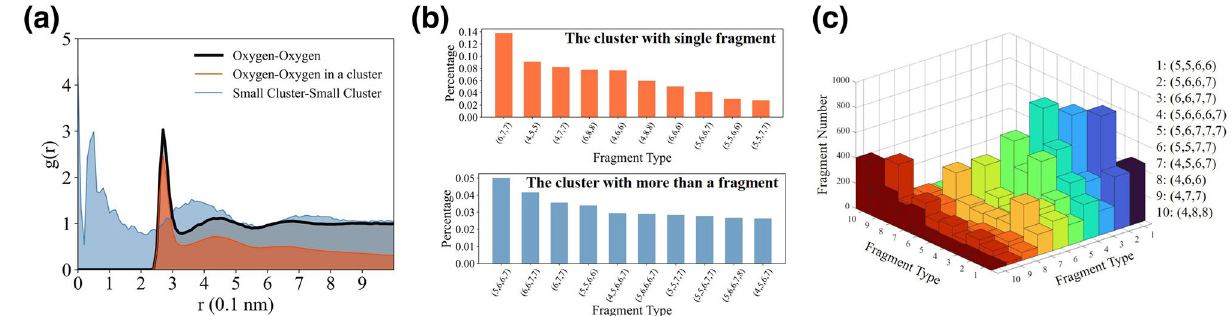
Figure 5. The oxygen–oxygen and cluster–cluster radial distance functions and topological properties of clusters. ( a ) The radial distance functions of oxygen–oxygen in global system, oxygen–oxygen in large clusters and small cluster-small cluster. The cluster RDF is calculated by the mass point of clusters with no more than 10 molecules. ( b ) The top 10 favored fragments in the clusters with a fragment and more than one fragment at 278 K. ( c ) The distributions of adjacent fragments in the clusters. Labels 1–10 represent most local favored fragments in the hydrogen bond